Question: Name the type of graph shown.
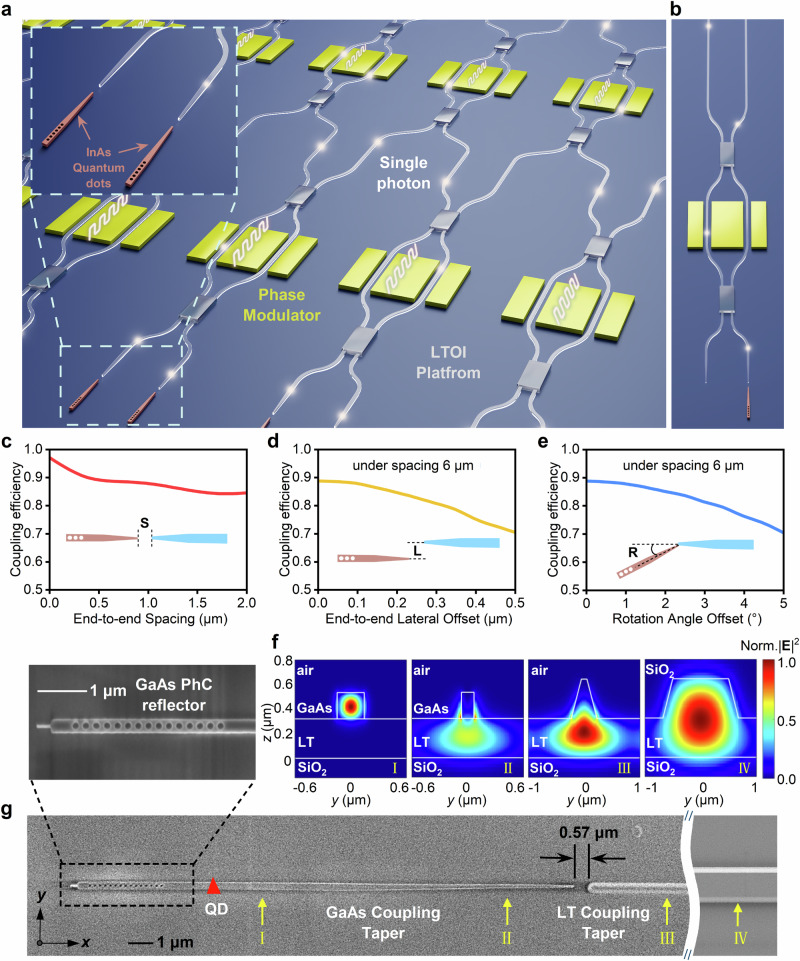
Answer: line